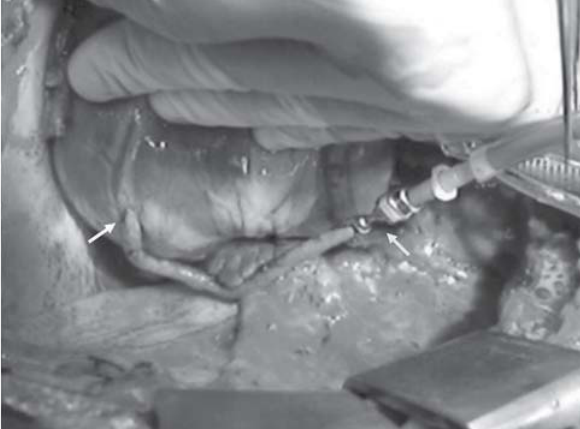
Fig. 1 - Foto do procedimento cirúrgico. Ponte de safena/coronária com anastomose distal realizada (seta à esq.) sendo submetida a cardioplegia sanguínea com fluxo de 100 ml/min (seta à dir.). Cateter em “Y” em conexão com a cardioplegia e em linha com o sistema transdutor de aferição da pressão